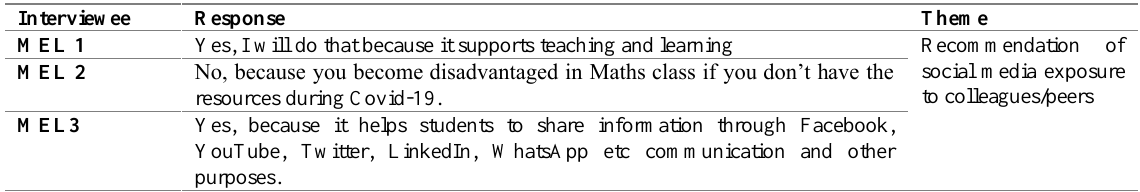
Table 5: Question 5 - Would you recommend students’ social media exposure to any colleague in either Mathematics department